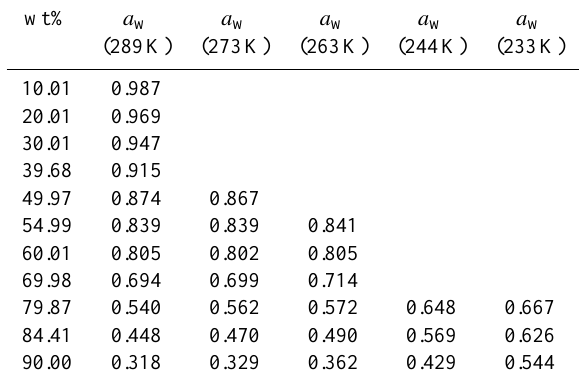
Table 10. Water activity (a w ) measurements ∗ of aqueous M5 so- lutions from EDB hygroscopic growth curves evaluated at the in- dicated weight fractions. The corresponding M5 solution composi- tions in terms of organic components are given in Table 9.